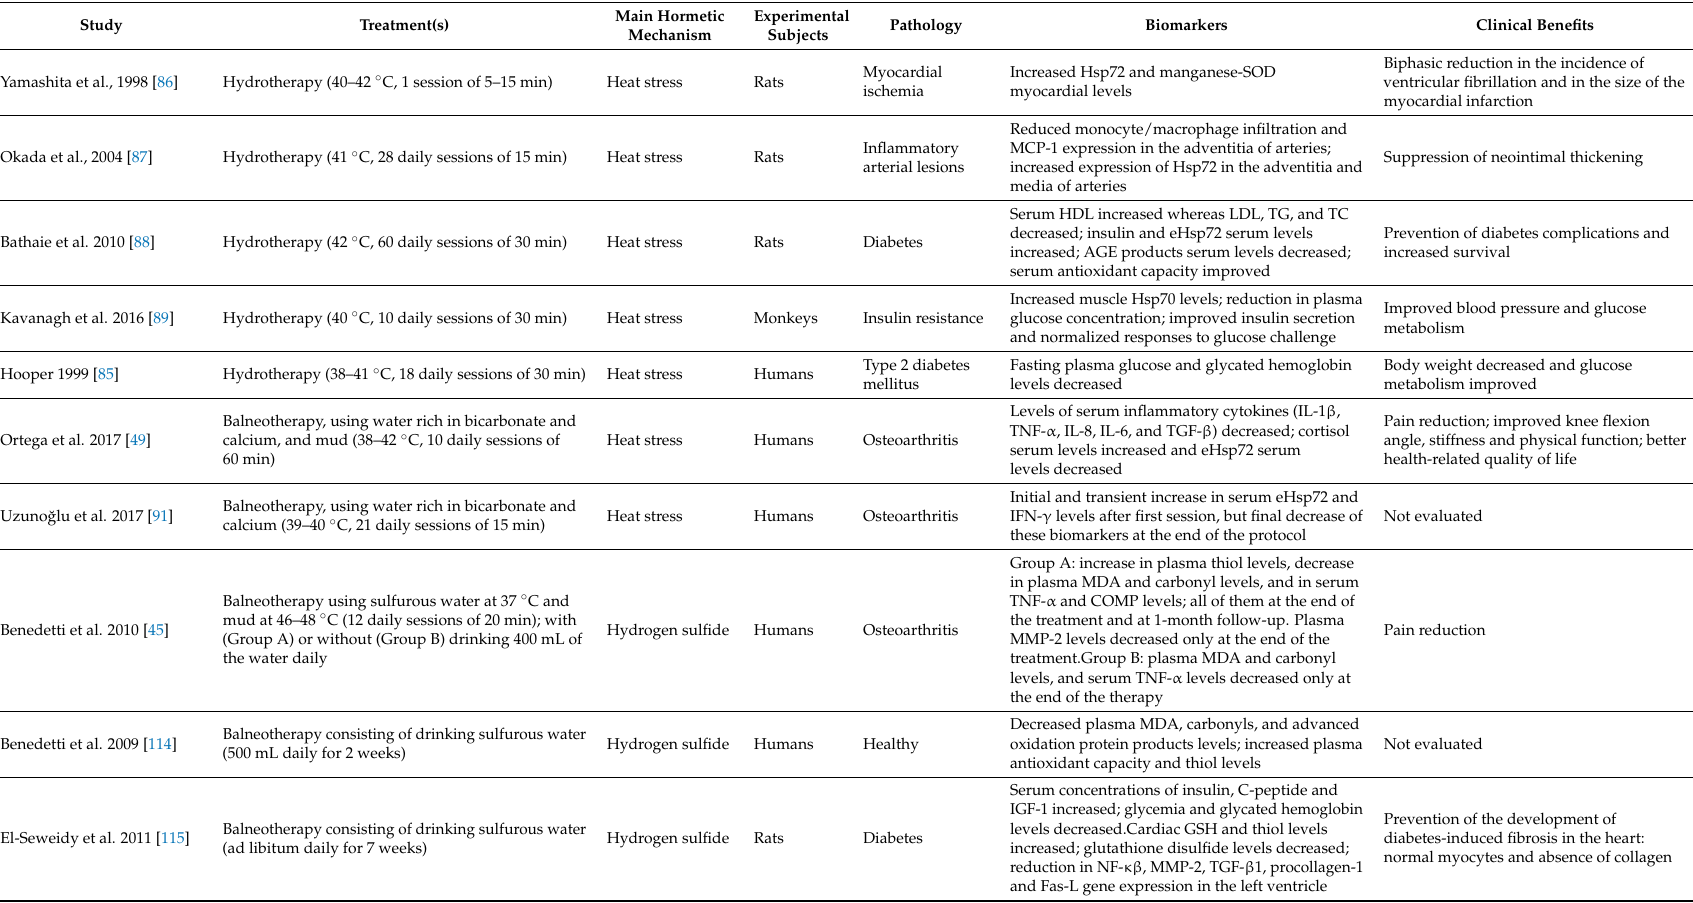
Table 1. Potential hormetic mechanisms and biomarkers mediating the clinical benefits of different modalities of spa